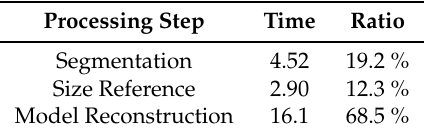
Table 4. Processing time of the whole